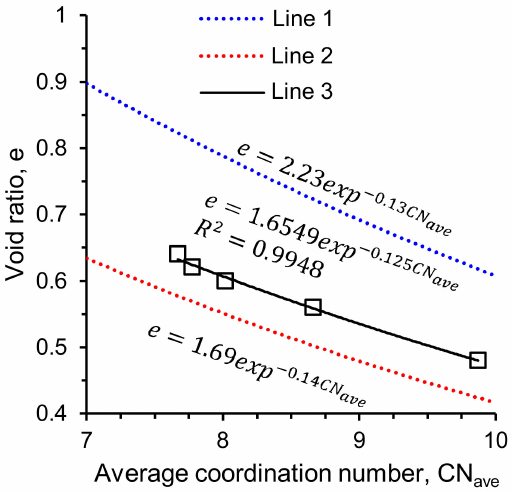
Figure 16. Correlation between average coordination number and void ratio of RBS particles